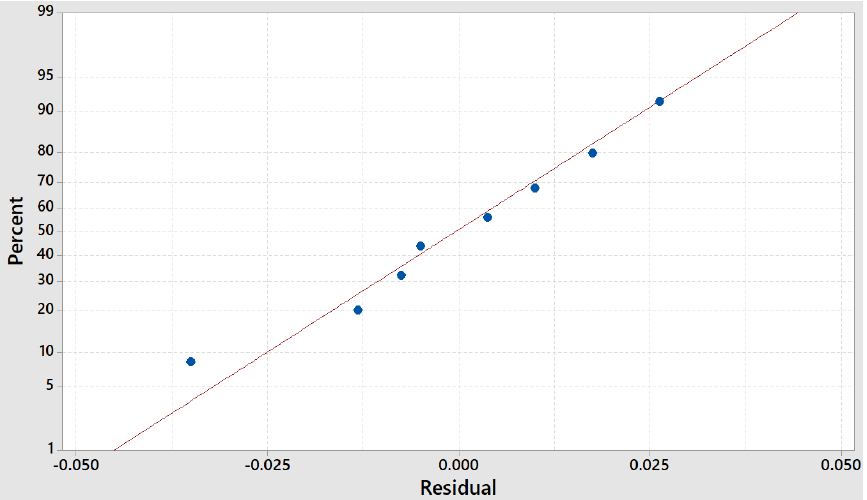
Figure 7. Normal probability plot—response in Ra (Taguchi case).